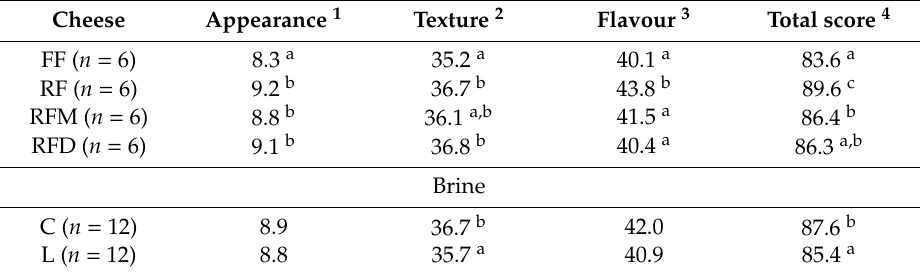
Table 6. Organoleptic evaluation of full-fat and reduced-fat sheep milk cheeses at 60 days of ripening. Cheese codes are according to Tables 1 and